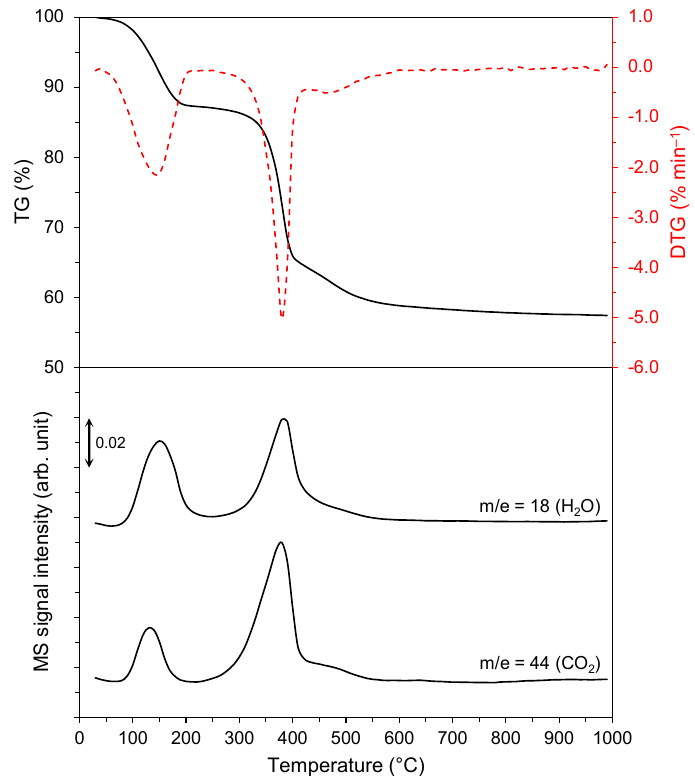
Figure 1. TGA-MS curve of the 5Mg-Al hydrotalcite (heating in airflow, temperature range 30–1000 °C); ( top ) TG and DTG curves, ( bottom ) selected mass signals of H 2 O and CO 2 (m/e = 18 and 44).